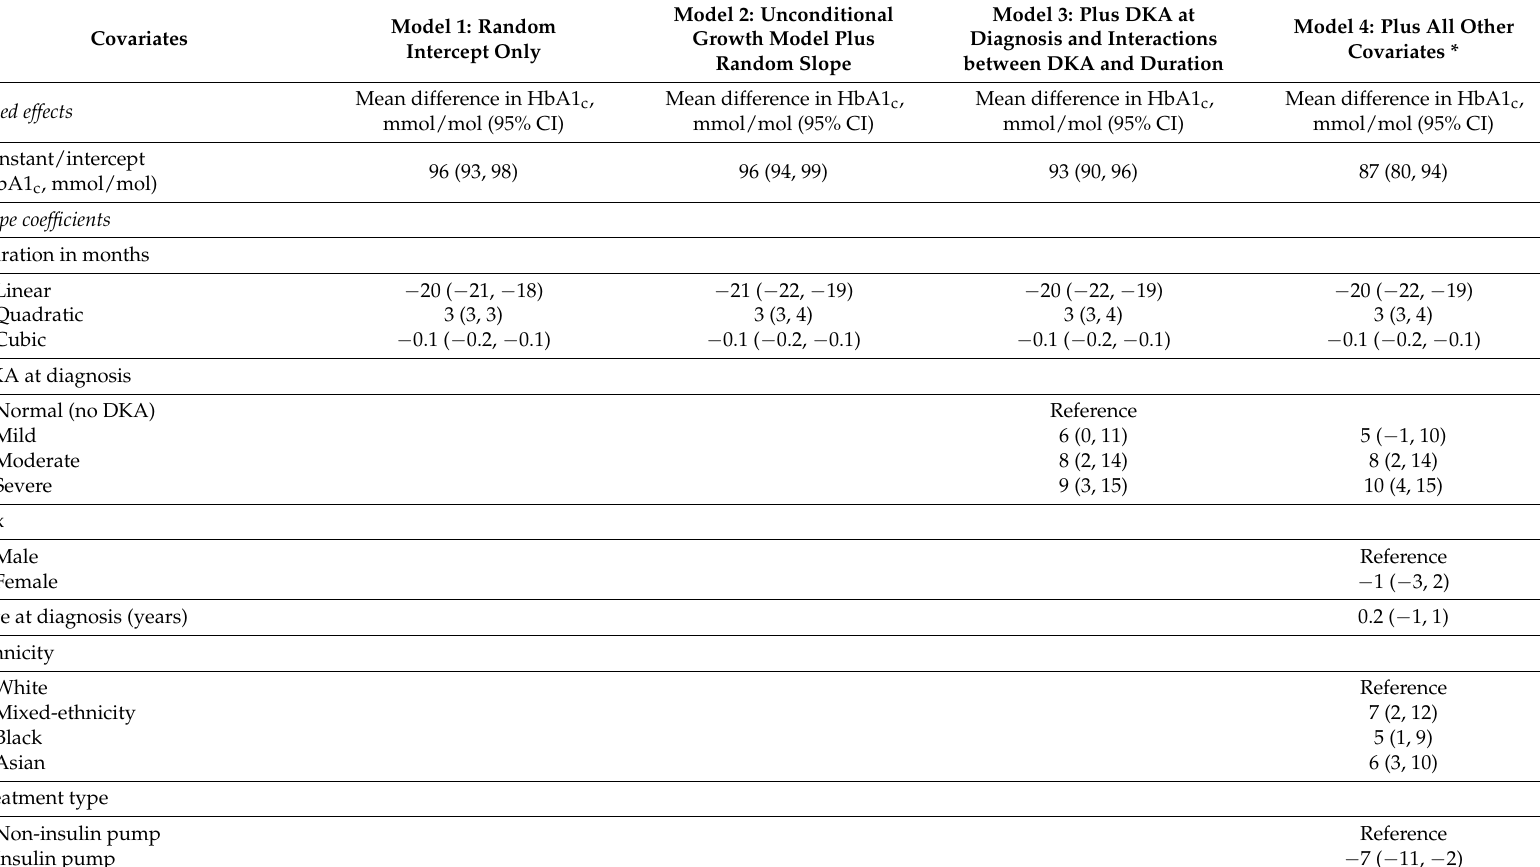
Table 3. Mixed effects models for longitudinal change in glycaemic control (HbA1 c ) during the first year post-diagnosis of type 1 diabetes in 364 children attending paediatric diabetes clinics in East